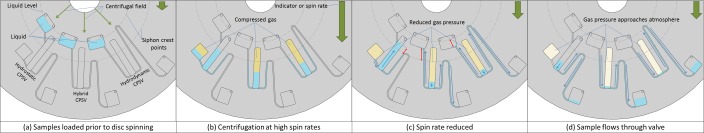
Comparison of Hydrostatic, Dynamic and Hybrid centrifugo-pneumatic siphon valves (CPSVs).Gas pressure is indicated in subfigures through the intensity of colour. (a) Liquid is loaded to the disc. (b) Upon spinning, the liquid advances into the central chamber while seeking hydrostatic equilibrium. However, the centrifugal compression of the gas volumes in the compartments enclosed by the liquid creates a counter pressure. (c, d) In the hydrostatic mechanism, the air in the closed side chamber expands upon reduction of the spin rate, so the liquid level in the open central chamber rises above the crest point of the siphon to forward the liquid into the open receiving chamber. In the hybrid CPSV, air is compressed in the closed central chamber during fast spinning. After lowering the angular frequency, the resulting decompression of air and the reduction of the centrifugal field jointly lift the liquid levels in the side arms above the crest point to empty the liquid into the open outer chamber. The operation of the dynamic CPSV follows a similar mechanism. However, the crest point of the siphon is now located above the level of the hydrostatic equilibrium; the siphon valve thus only opens upon rapid change of the spin rate so inertia propels the flow until the meniscus in the outlet channel has protruded past the liquid level in the central chamber.